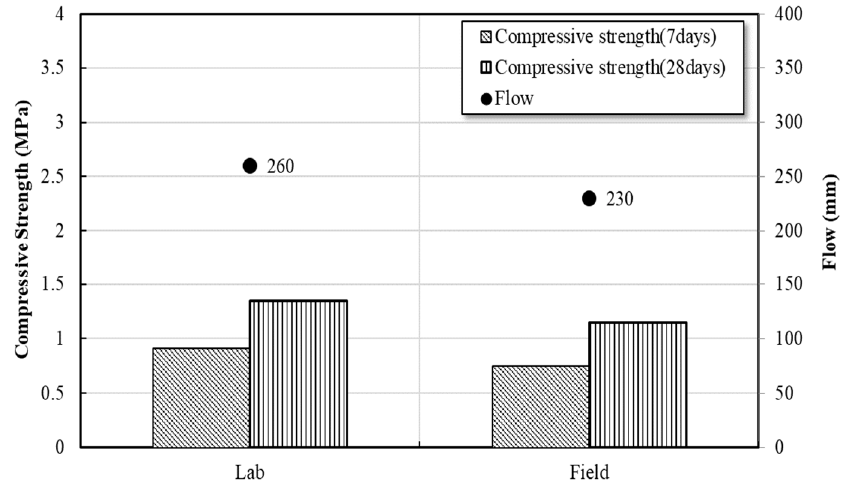
Figure 11. Field and lab test evaluation results for the CLSM using stone sludge.